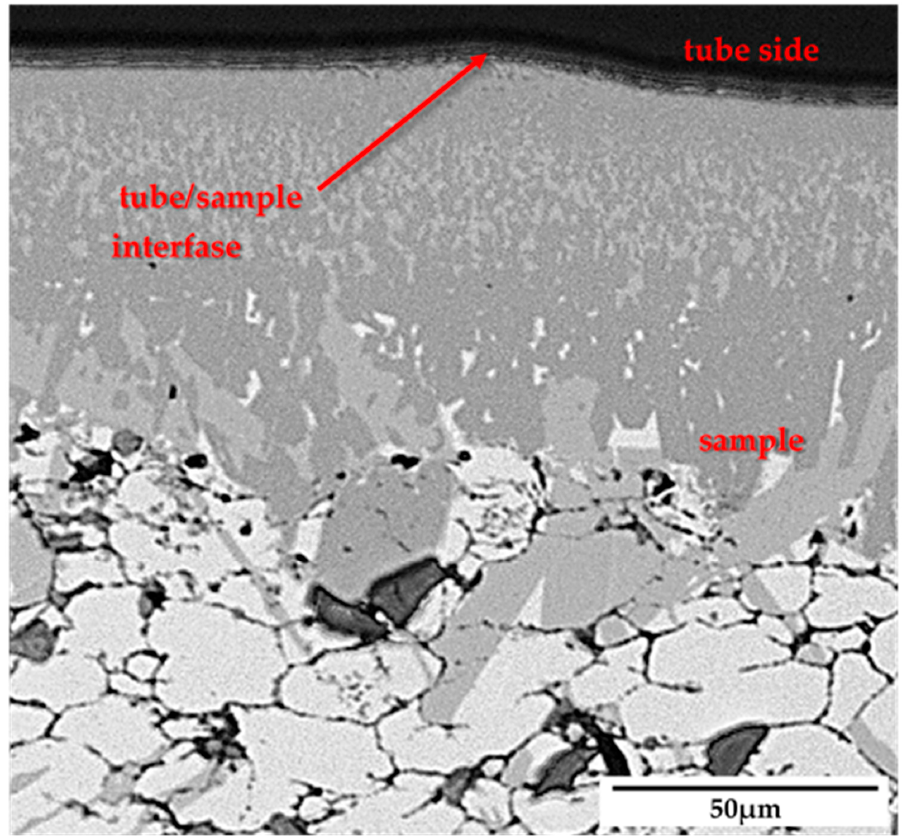
Figure 7. Al-14Ce wt % via PIT showing the formation of Fe/Ni rich phase at the tube/sample inter- face after the removal of the stainless-steel